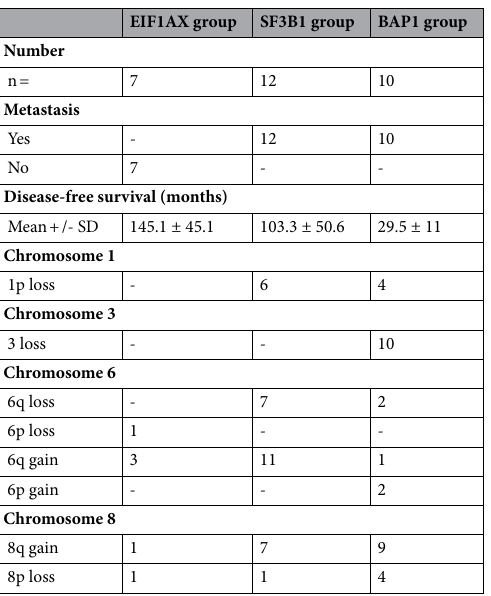
Table 1. Clinical and molecular characteristics of the 29 primary UM